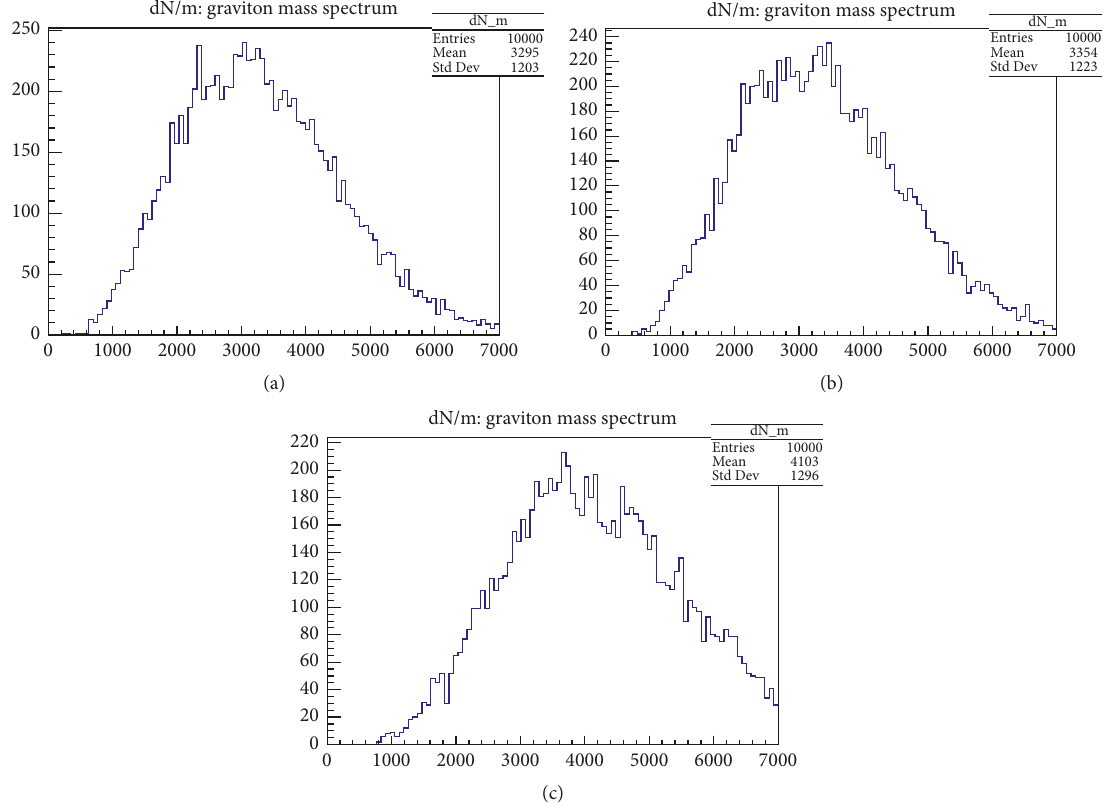
Figure 5: Graviton mass spectrum within monojet LED model for three graviton, G, emission processes: (a) gg → 𝐺𝑔 , (b) qg → 𝐺𝑞 , and (c) 𝑞𝑞 → 𝐺𝑔 at the center of mass energies of